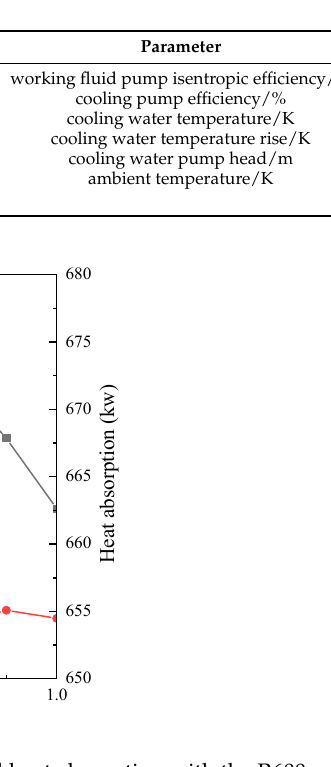
Figure 6. Variation of the optimal flash pressure and heat absorption with the R600 mole fraction.